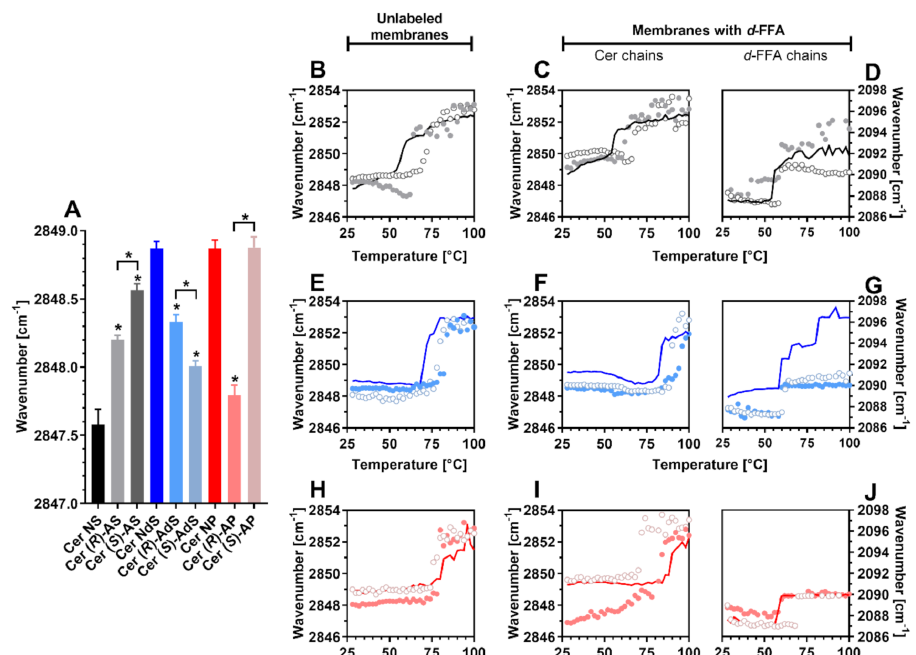
Figure 3. Chain order and phase transitions (FTIR spectra) in Cer/( d )-FFAs/Chol/CholS membranes containing either sphingosine (Cer NS, Cer ( R )-AS, or Cer ( S )-AS; Panels ( B – D ) or dihydrosphingosine (Cer NdS, Cer ( R )-AdS, or Cer ( S )-AdS; Panels ( E – G ) or phytosphingosine Cers (Cer NP, Cer ( R )-AP, or Cer ( S )-AP; Panels ( H – J ) at ambient room humidity. Panel ( A ) shows methylene symmetric stretching wavenumbers at a physiological temperature of 32 ◦ C as means ± SEM, n = 4. Asterisks indicate statistically significant differences against the controls with non-hydroxylated Cers (Cer NS or Cer NdS or Cer NP) ( p < 0.05). The graphs in panels ( B , E , H ) show the temperature dependence of the methylene symmetric stretching FTIR spectra of model SC lipid membranes with unlabeled lipids. The lines belong to membranes based on non-hydroxylated Cers, filled circles belong to membranes based on ( R )- α -hydroxy Cers, and open circles belong to ( S )- α -hydroxy Cer membranes. The behavior of the samples with d -FFAs is shown in the panels: ( C , D ) sphingosine Cers, ( F , G ) dihydrosphingosine Cers, and ( I , J ) phytosphingosine Cers, where Panels ( C , F , I ) describe the Cer chains (CH 2 vibrations) and Panels ( D,G , J ) show the d -FFA chains (CD 2